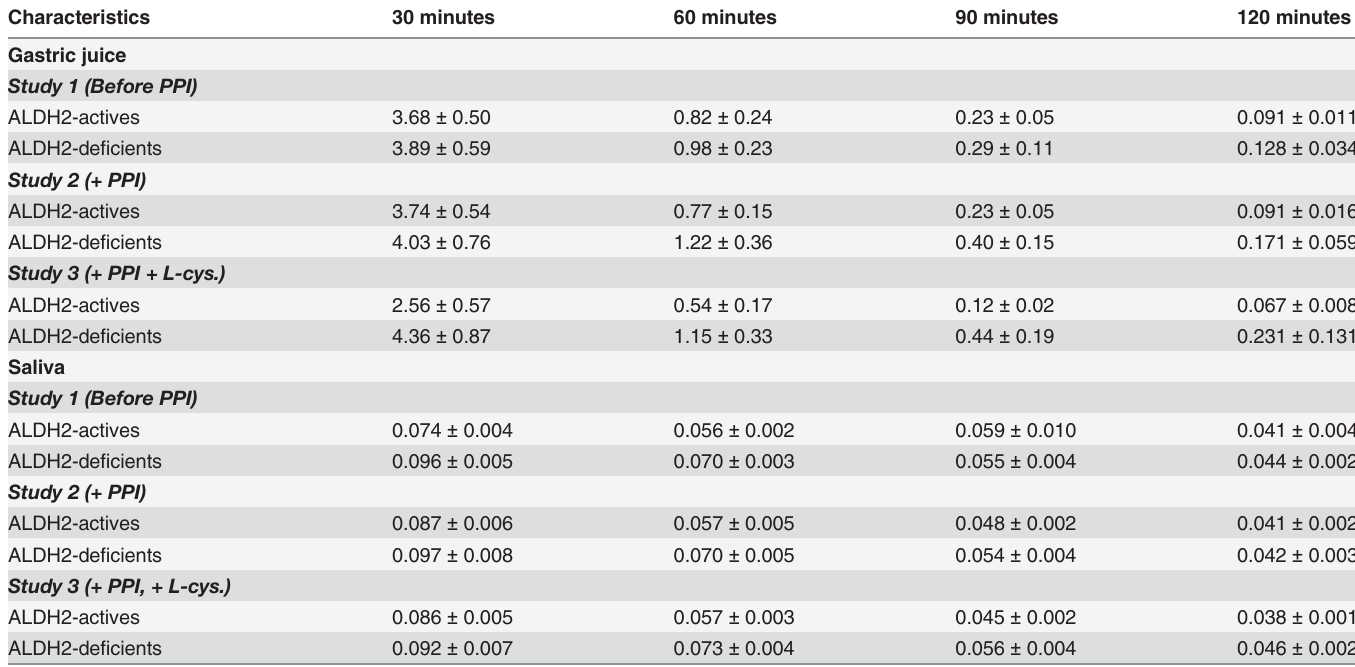
Table 1. Ethanol levels (vol %) in gastric juice and saliva after intragastric administration of ethanol (15 vol%, 0.5 g/kg) (means ± SEM).